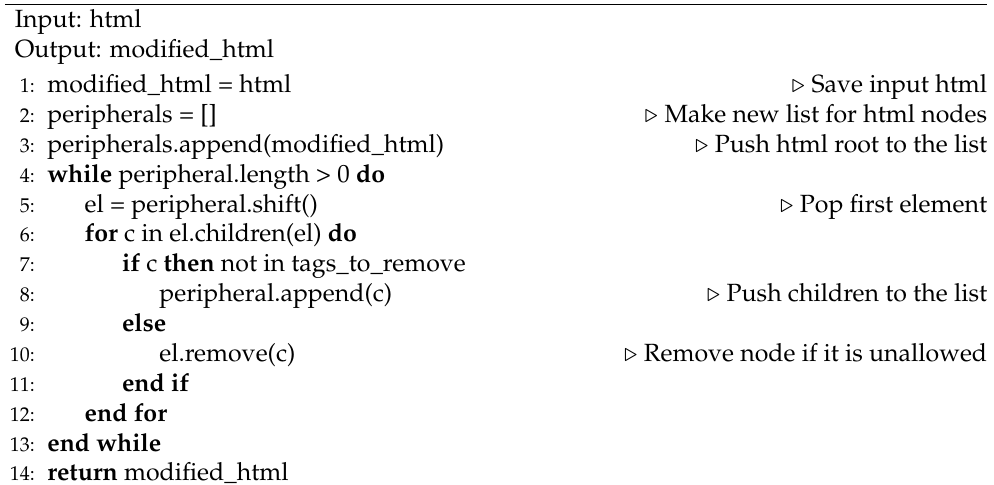
Algorithm 3 Algorithm of remove_tags function removing all unallowed HTML